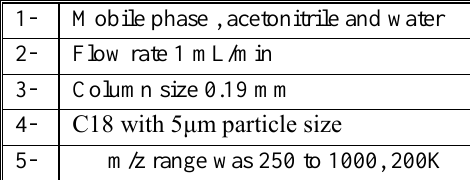
Table 1. LC mass condition for flavonoid